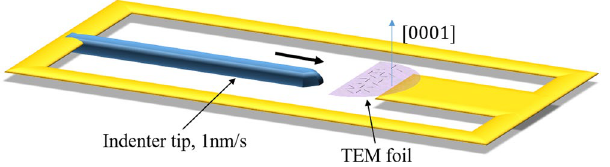
Figure 10. Schematic of in situ straining setup. The TEM foil in this figure is selected with its normal (blue arrow) closely parallel to [0001]. Black dashes in foil represent precipitates of three different variants. The indentation direction is indicated by thick black